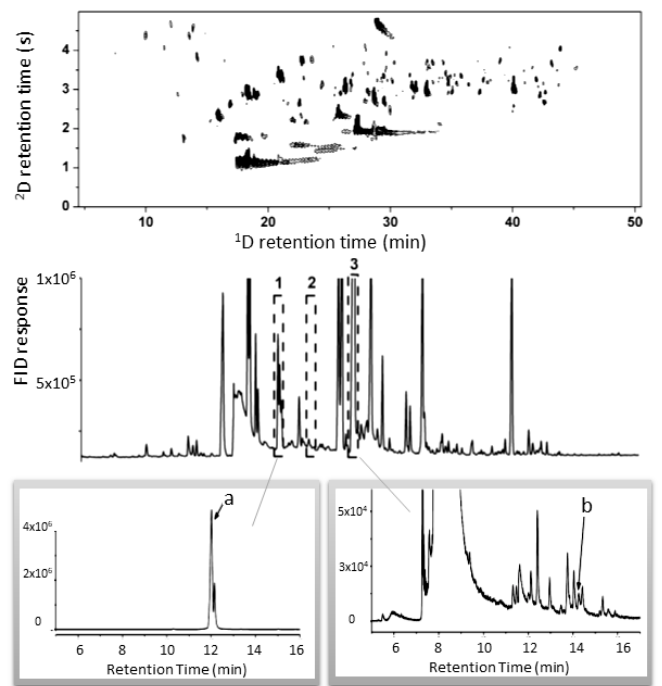
Figure 4. GC × GC- flame ionisation detection (FID) volatile profile of ground roasted co ff ee ( top panel). 1 D GC-FID chromatogram indicating three regions to be heart-cut ( centre ). 2 D GC-FID results of the heart-cut of regions 1 and 3 ( bottom ). Peaks (a) and (b) are odour-active compounds responsible for the nutty and floral notes perceived in the target regions, respectively. Source: adapted with permission from Chin et al. [9].